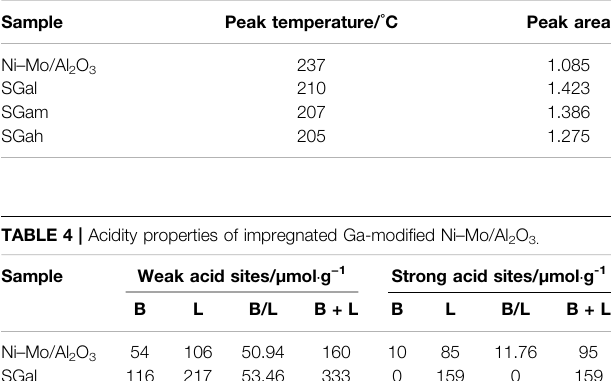
TABLE 3 | NH 3 -TPD results of impregnated Ga-modi fi ed Ni – Mo/Al 2 O 3. Sample